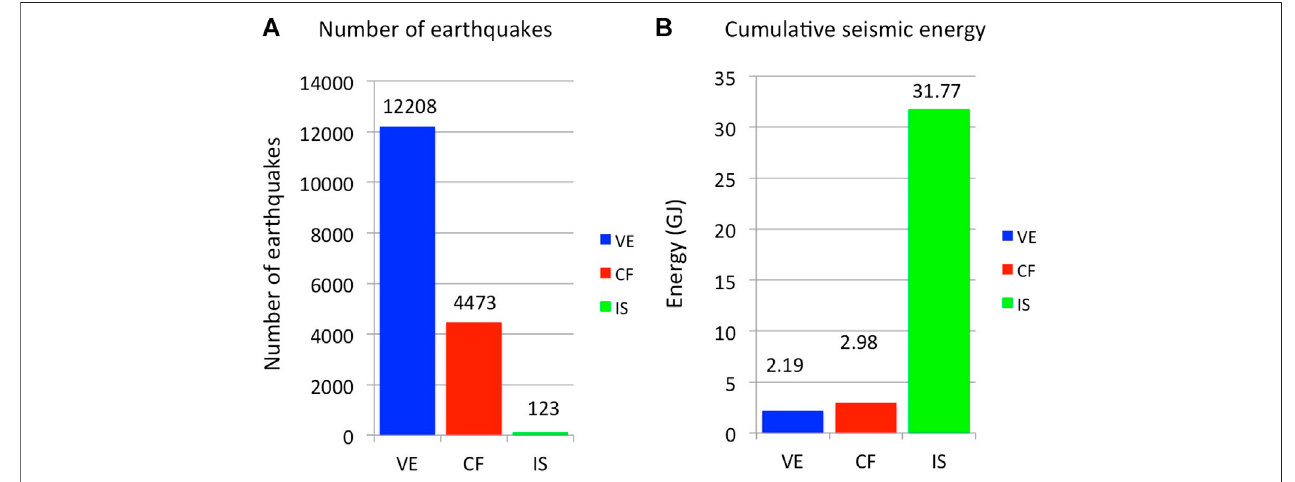
FIGURE 13 | (A) Bar charts showing the number of earthquakes recorded on Vesuvius (blue), Campi Flegrei (red) and Ischia (green) from January 2007 to December 2020. (B) Cumulative energy of the earthquakes from January 2007 to December 2020 of Vesuvius (blue), Campi Flegrei (red) and Ischia (green).